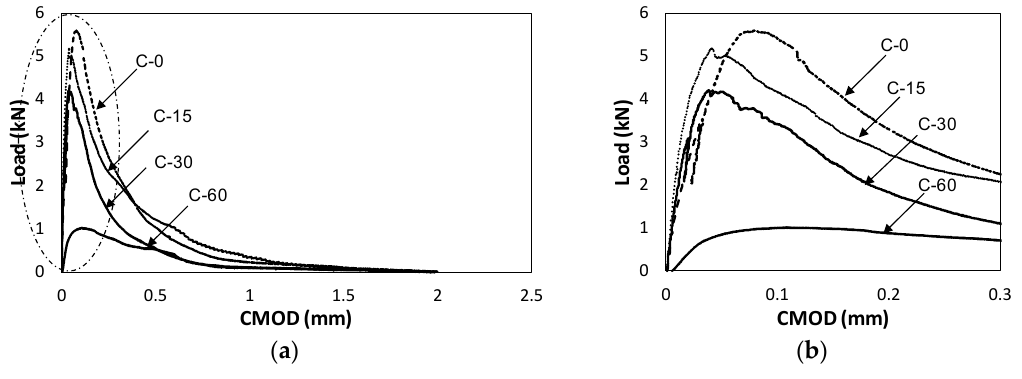
Figure 9. ( a ) Load–CMOD curves for C type specimens; and ( b ) enlarged graph.